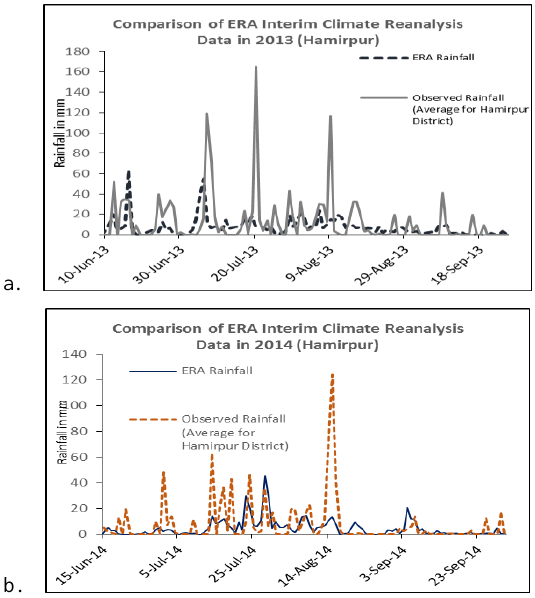
Figure 5: Plot of time series rainfall data from ERA and gauging